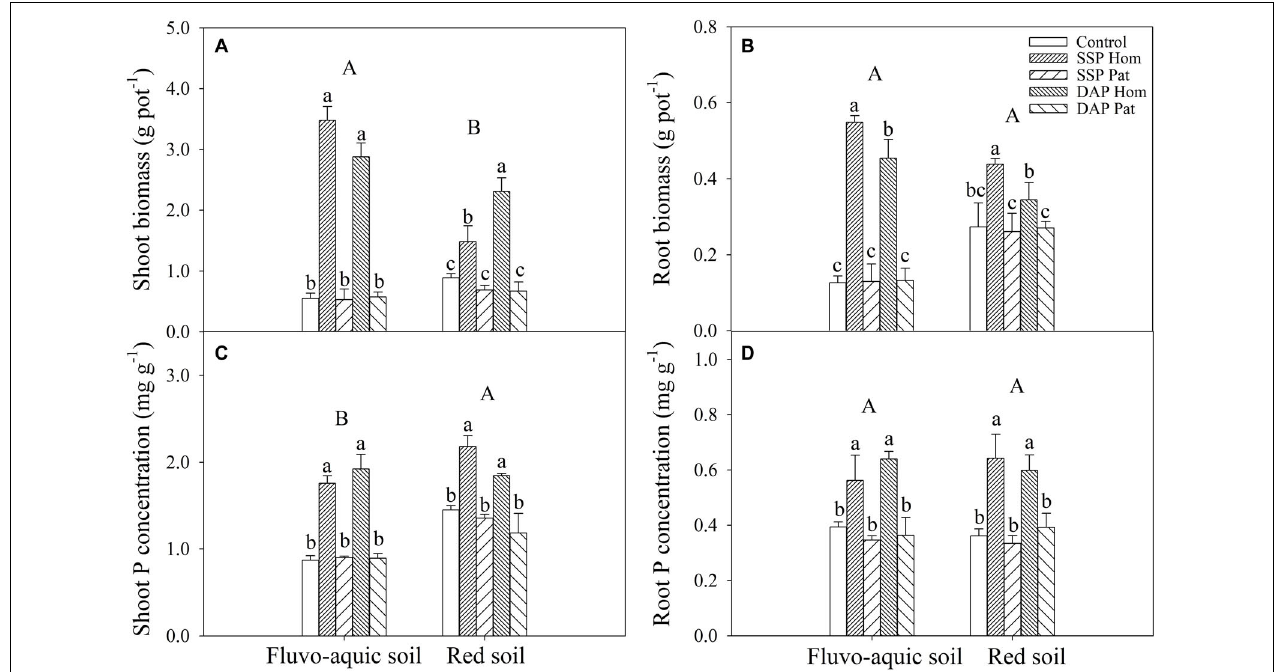
FIGURE 1 | Shoot and root biomass (A,B) and P concentration (C,D) of maize on 30 DAS in fluvo-aquic soil and red soil. Capital letters indicate significant differences between different soil types, and lower-case letters indicate significant differences between fertilization treatments. Each column refers to the mean value of four replicates